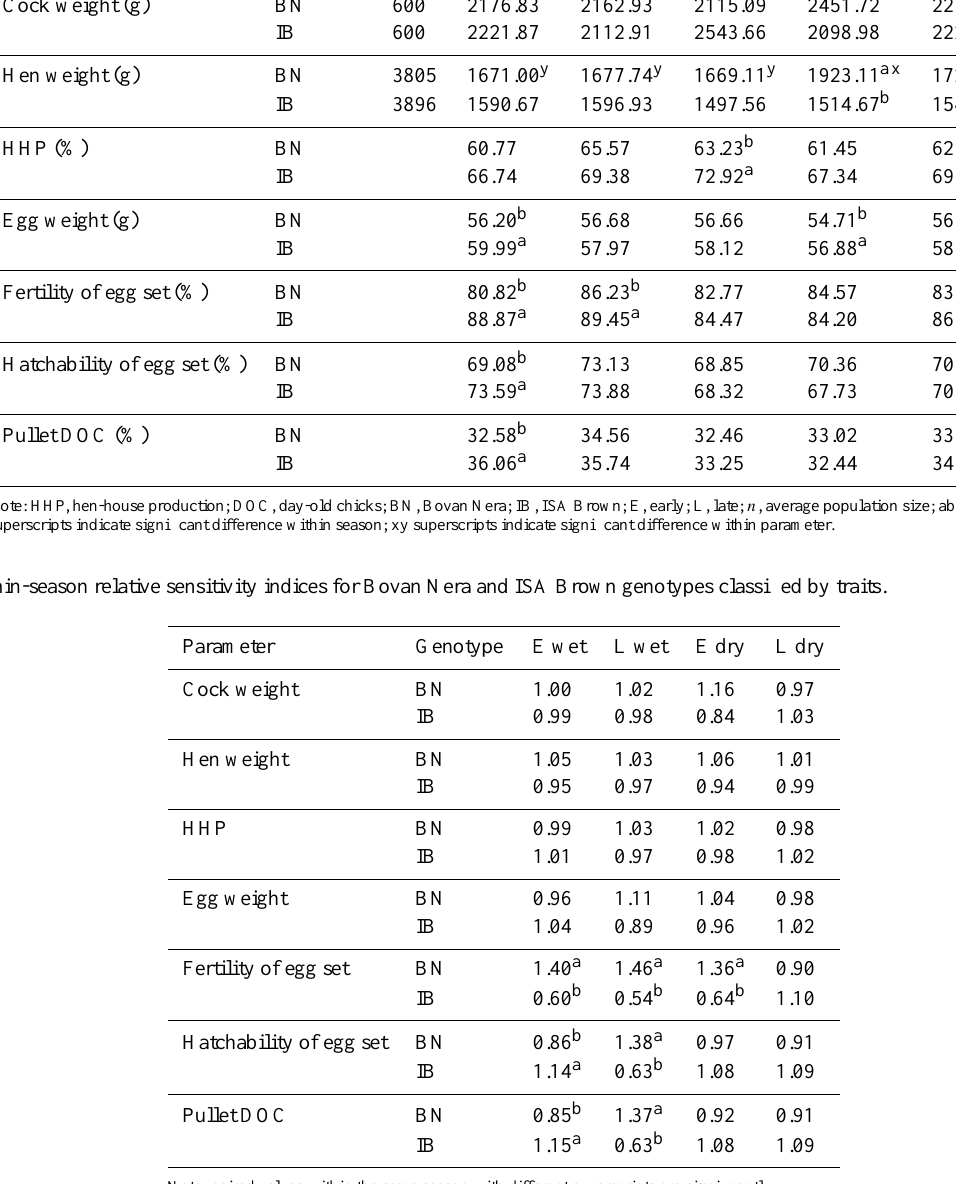
Table 2. Mean weight, productive and reproductive output of Bovan Nera and ISA Brown chickens in Ibadan. Parameter Genotype n E wet L wet E dry L dry Mean Cock weight (g) BN 600 2176.83 2162.93 2115.09 2451.72 2214.14 IB 600 2221.87 2112.91 2543.66 2098.98 2226.63 Hen weight (g) BN 3805 1671.00 y 1677.74 y 1669.11 y 1923.11 ax